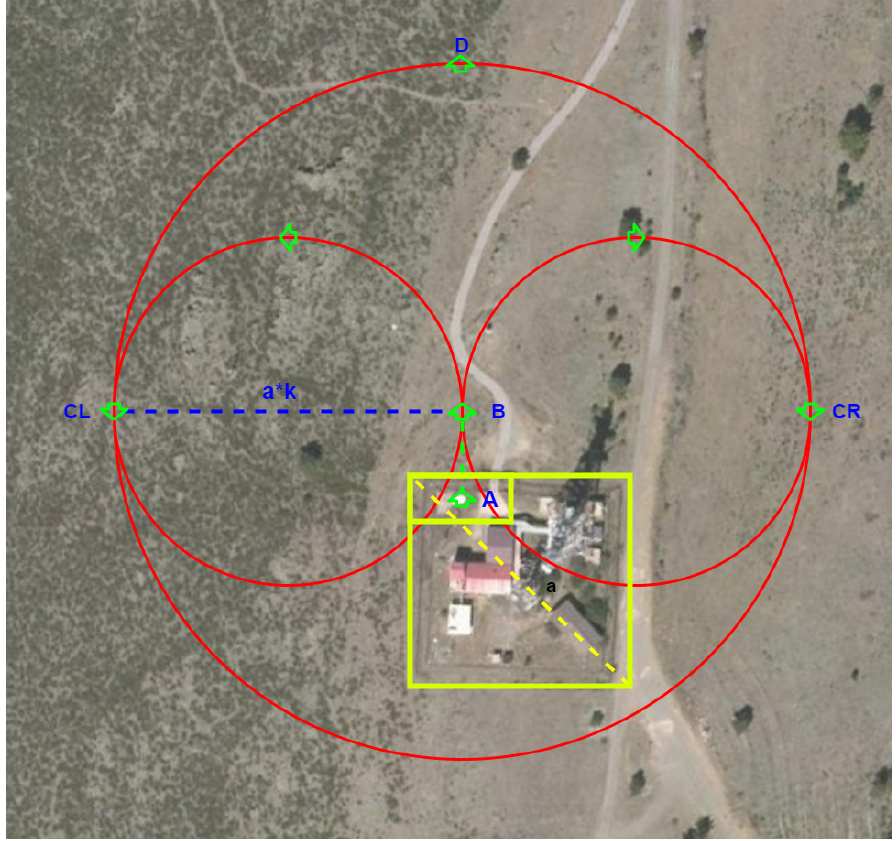
Figure 8. Safety take-off path